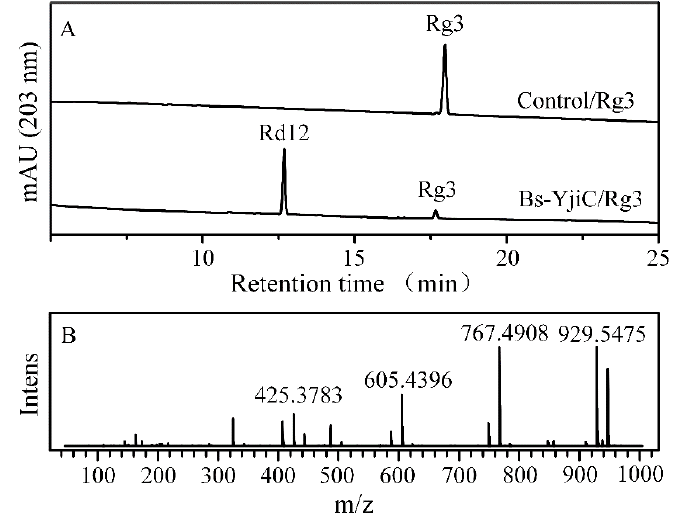
Figure 3. HPLC-ESI-MS analysis of the reactants of ginsenoside Rg3. ( A ) HPLC chromatograms of the reaction mixtures. ( B ) MS spectra for ginsenoside Rd12.